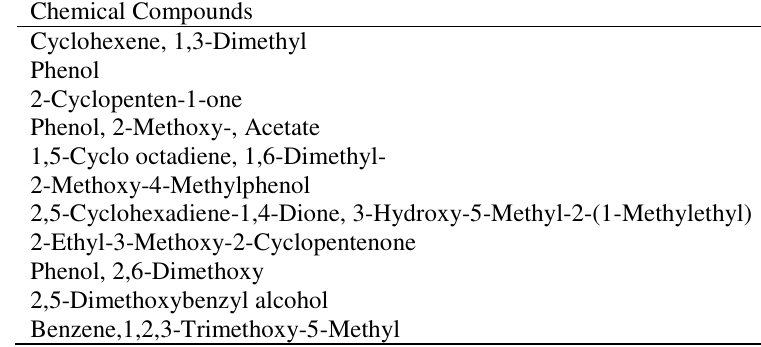
Table 1. The chemical compounds identified in the aqueous distillate of Borassus flabellifer Linn. shell extract by GC-MS analysis